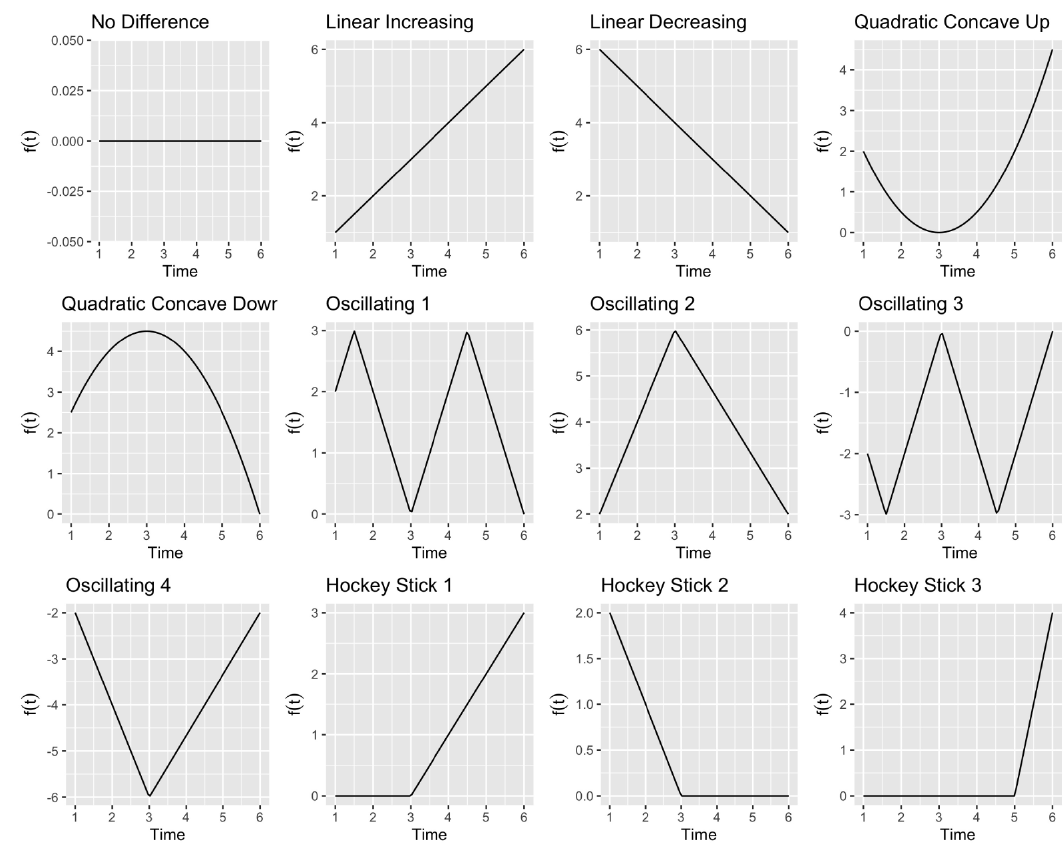
Figure 1. Different functional forms available using the mean_trend()